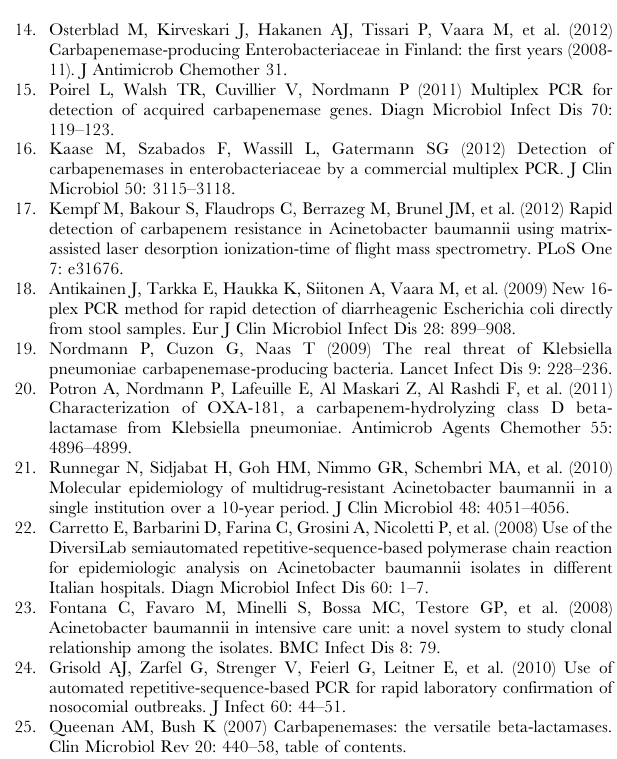
Table S1 Acinetobacter isolate description. Table S2 Species included in analytical specificity